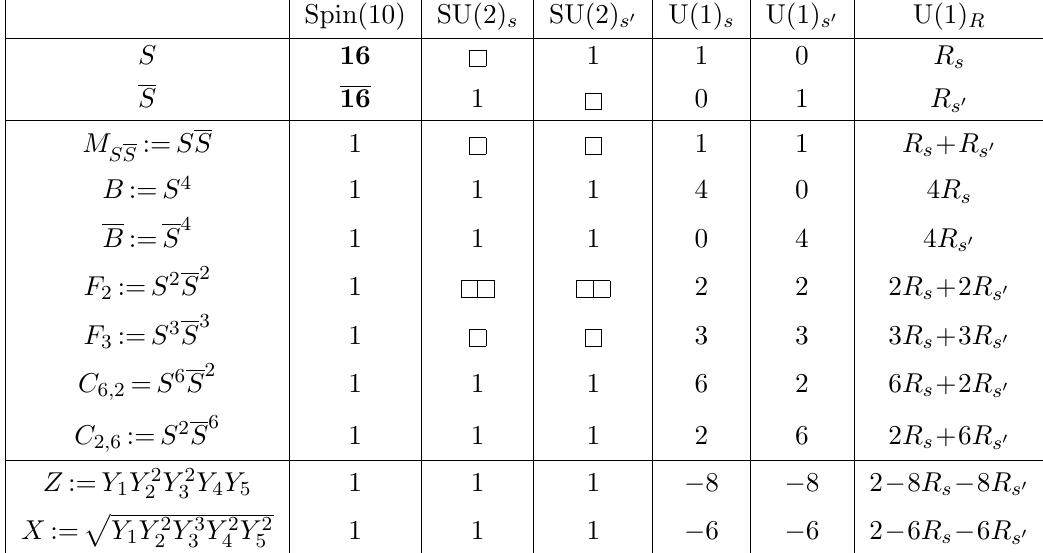
Table 17 . 3d N = 2 Spin(10) theory with ( N v ; N s ; N s 0 ) = (0 ; 2 ;